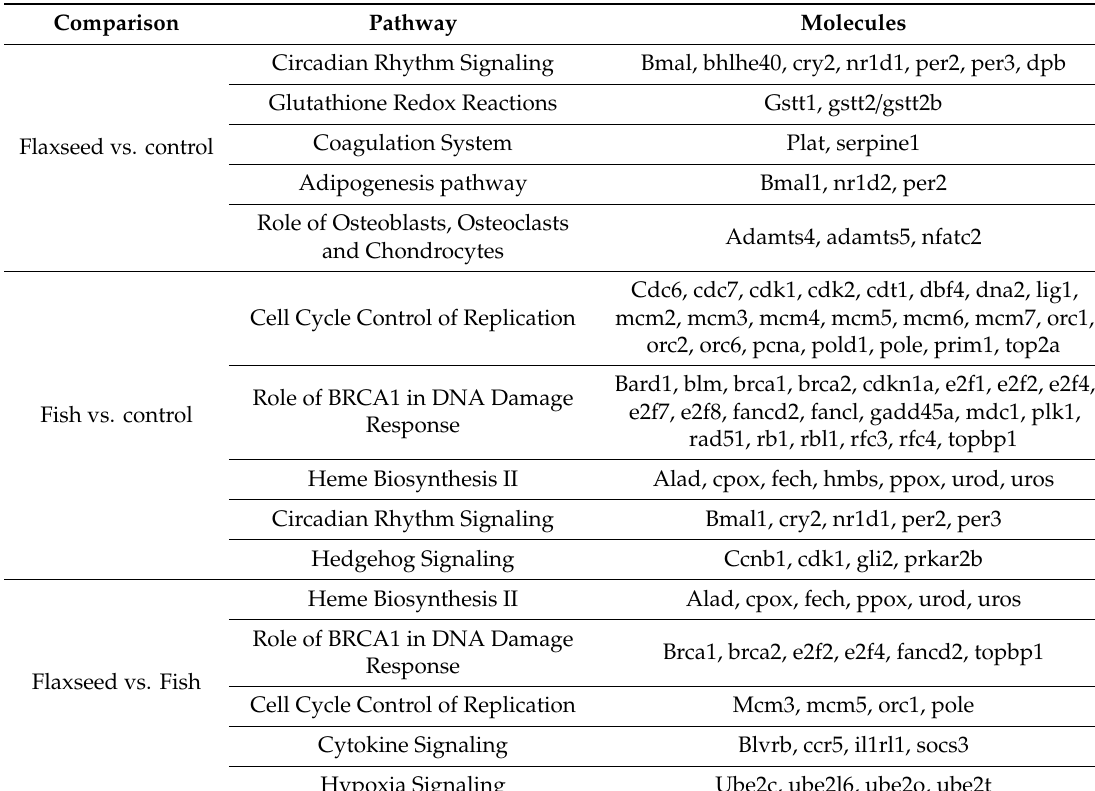
Table 7. Five Selected IPA canonical pathways and the genes involved in each